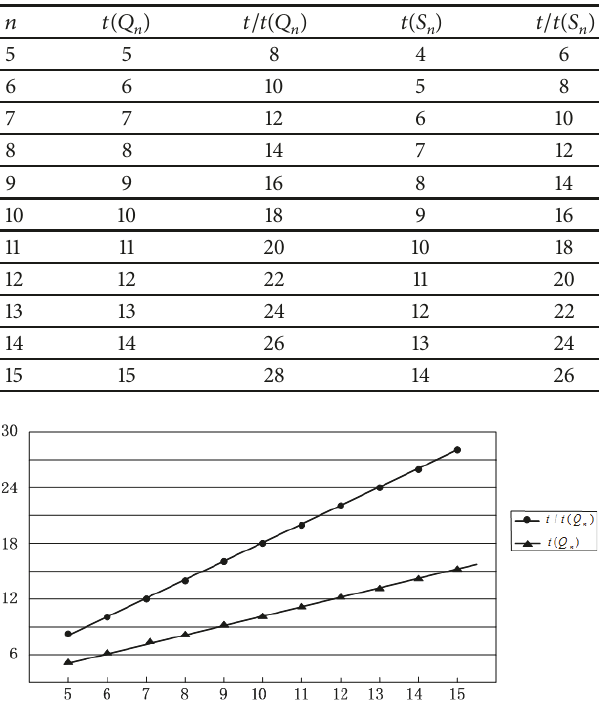
Figure 3: Comparison of classical diagnosability and 𝑡/𝑡 - diagnosability of 𝑛 -dimensional hypercube